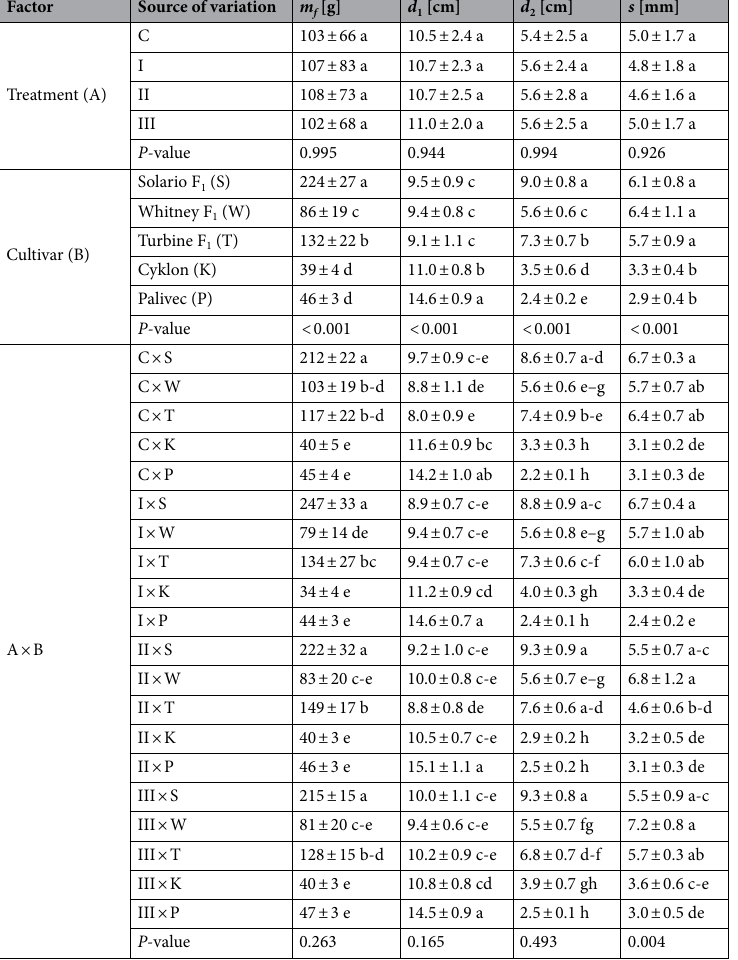
Table 3. Effect of the combined application of biostimulants on the biometric parameters (mean values ± standard deviations) of fruit in the analyzed cultivars of Capsicum annuum . Means followed by different letters are significantly different for each parameter (the level of significance, the p -value, is shown in the table).